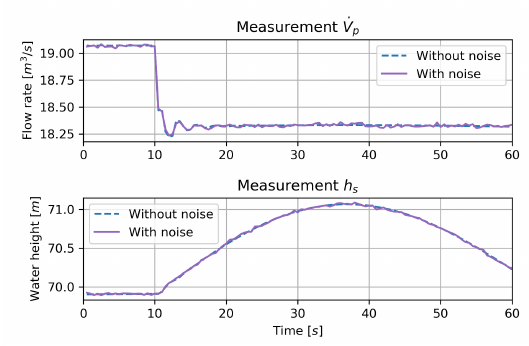
Figure 9: Measurements from the more detailed hy- dropower